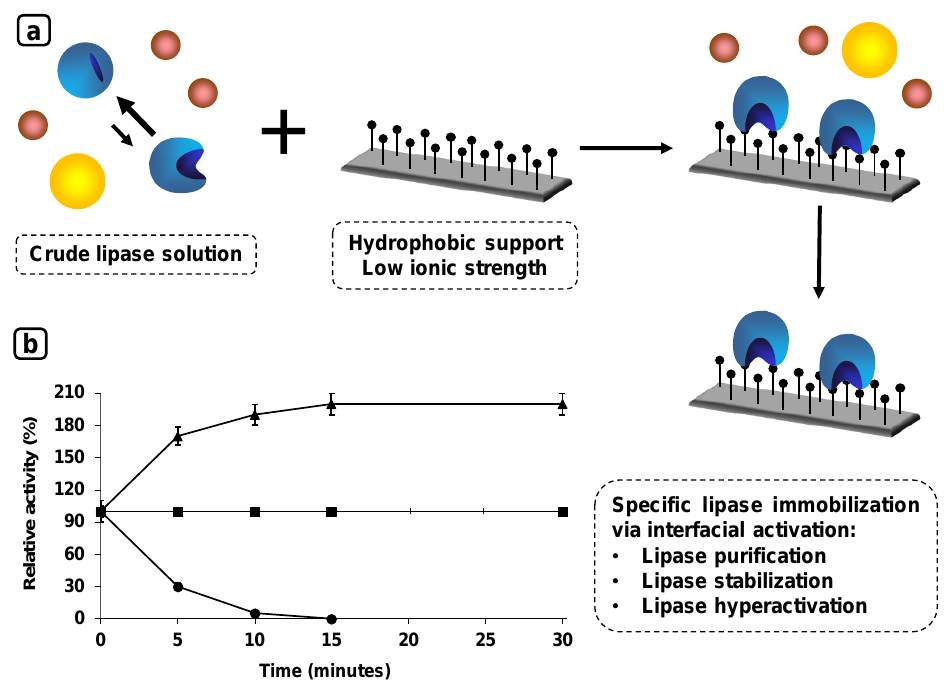
Figure 18. ( a ) Interfacial activation of lipases on hydrophobic supports at low ionic strength: stabilized, purified and hyperactivated enzyme form. ( b ) Standard immobilization course of lipases on hydrophobic supports. Solid triangles: Suspension. Solid Squares: Reference. Solid circles: Supernatant.